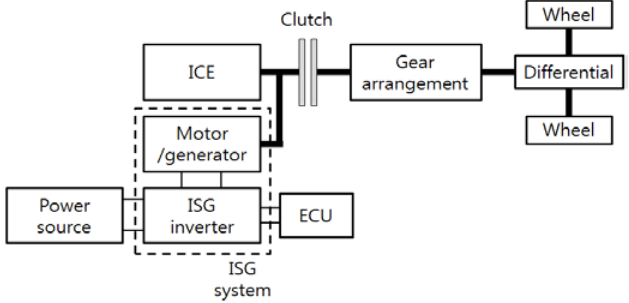
Figure 1. Schematic diagram of a 42 V integrated starter generator (ISG) system in hybrid electric vehicles (HEVs) [11]. ICE: internal combustion engine; ECU: electronic control unit.